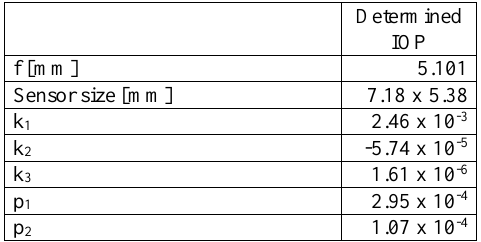
Table 2. Parameters of indoor camera